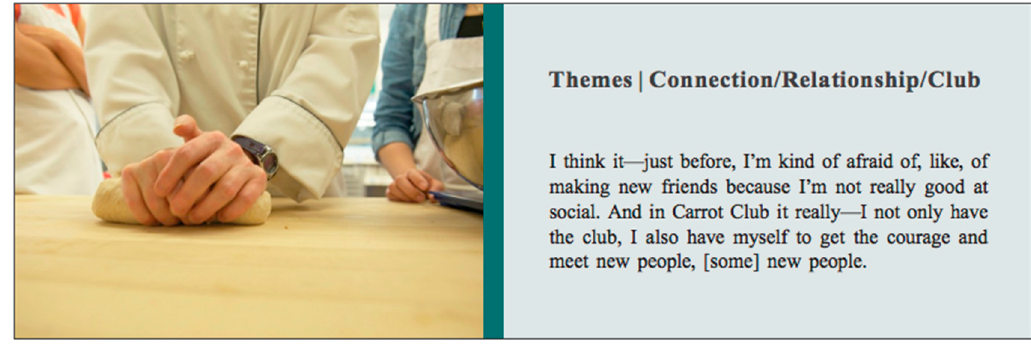
Figure 1. Photovoice artifact #1.